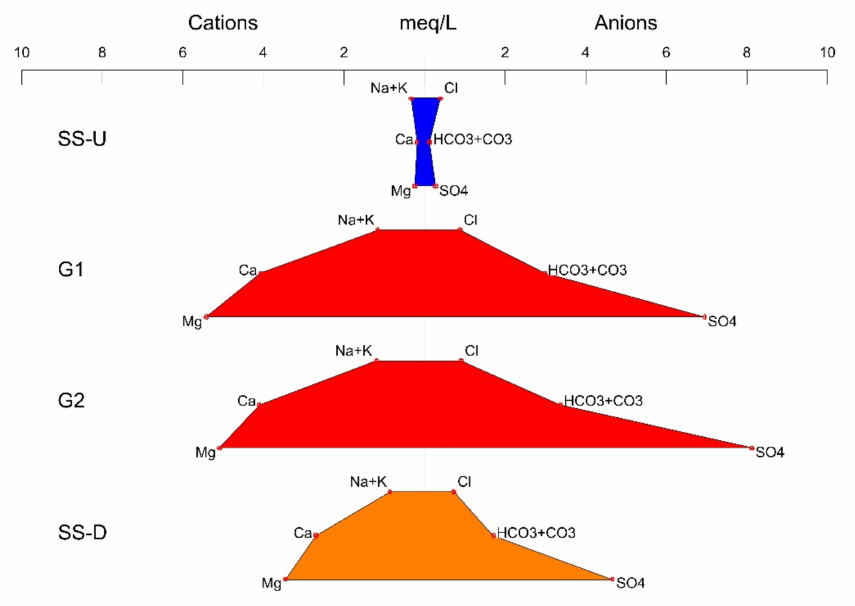
Figure 5. Stiff diagram of the studied waters (average values from April 2017 to December 2019, n =